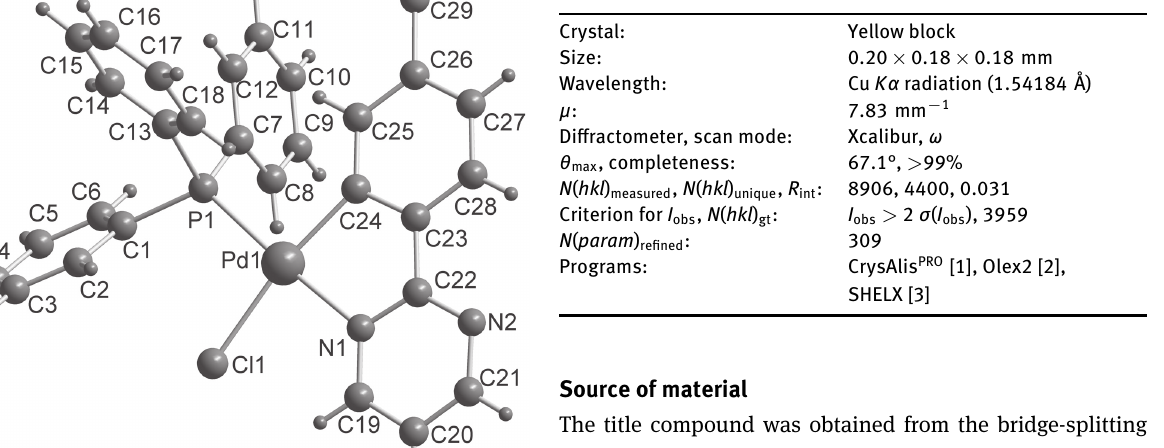
Table 1: Data collection and